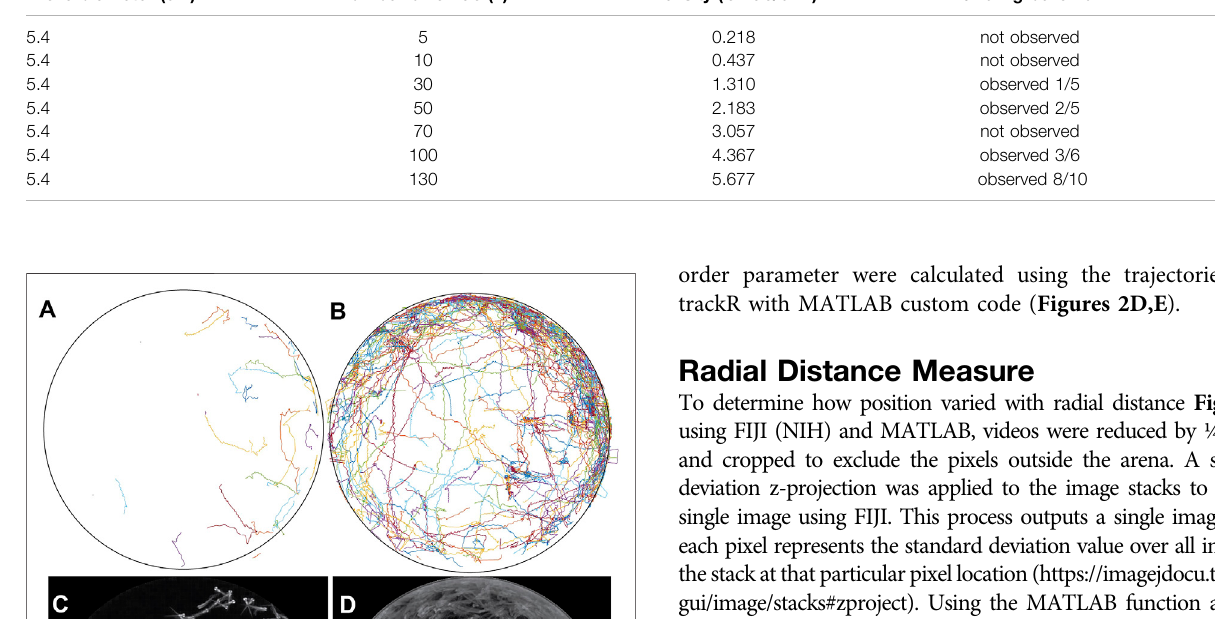
Frontiers in Physics |